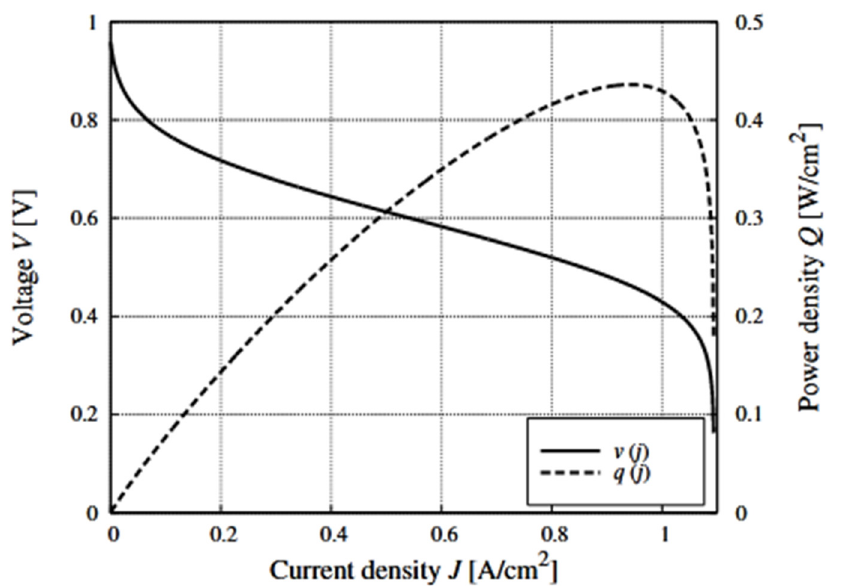
Figure 5. Voltage v and power density q of a single fuel cell typical element versus its current density j. The voltage varies from about 1 V to about 0.5 V when the power increases from zero to its maximum value.